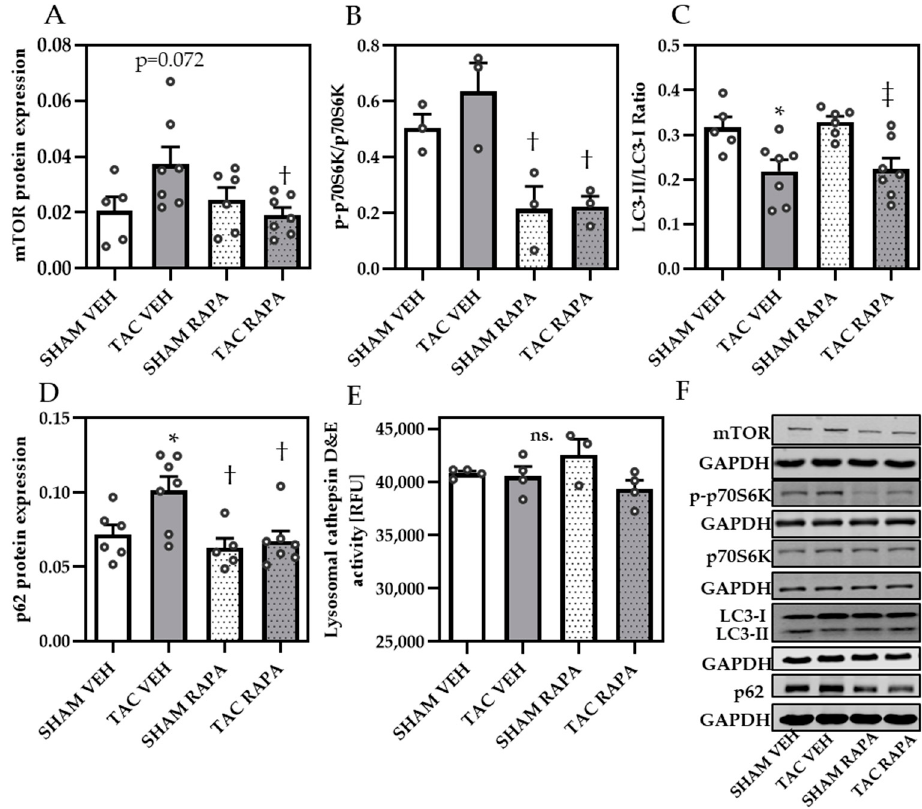
Figure 3. Rapamycin decreased mTOR- and increased autophagy-related proteins in TAC mice. Immunoblot analysis of: ( A ) mTOR, ( B ) p-p-70S6K/p-70S6K, ( C ) LC3-II/GAPDH to LC3-I/GAPDH ratio, ( D ) p62. ( E ) Maximal lysosomal cathepsin D&E activity. ( F ) Representative immunoblots of all mentioned proteins. Immunoblot data are normalized to GAPDH and all data are presented as Mean + SEM of biological replicates. Statistical analyses were performed by two-way-ANOVA followed by Tukey’s posttest. Statistically significant differences are shown by p < 0.05, * vs. SHAM VEH, † vs. TAC VEH and ‡ vs. SHAM RAPA, ns = not